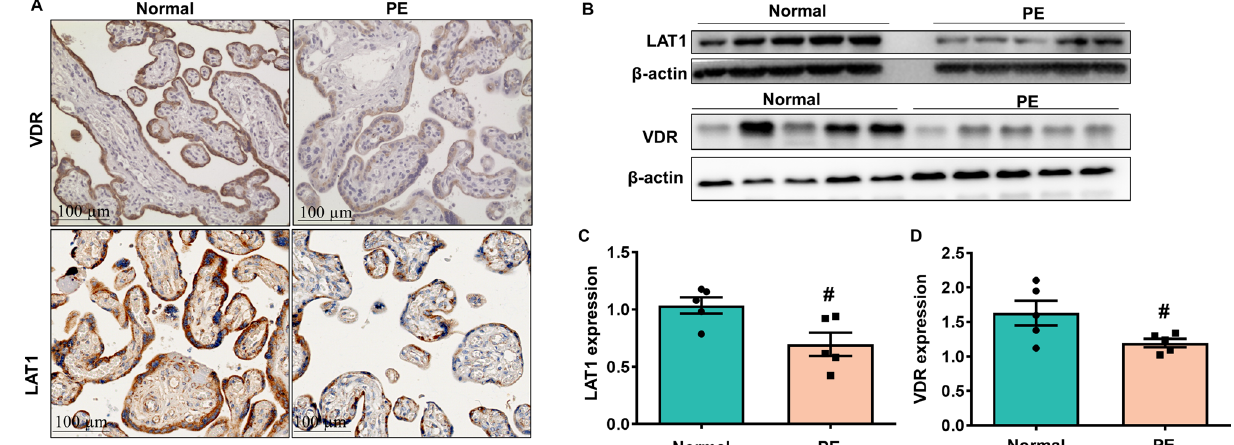
Figure 1. Expression of LAT1 and VDR in normal and preeclamptic placentas. ( A ) Representative immunostaining images of LAT1 and VDR expressions in tissue sections from normal and preeclamptic (PE) placentas. Bar = 100 micron. ( B ) Representative blots of LAT1 and VDR expression in placenta from normotensive and PE pregnancies. ( C,D ) The bar graphs show the relative density of protein expression for LAT1 and VDR after normalization with β-actin expression in each sample. n = 5, # P < 0.05, PE vs